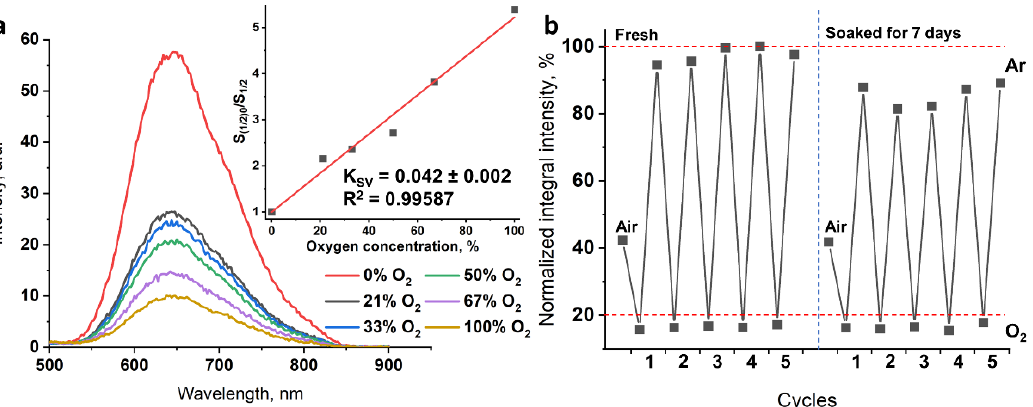
Figure 5. ( a ) Luminescence spectra of aqueous solutions of 1 0.5 @pU in different mixtures of O 2 /Ar atmosphere and under air conditions (21% of oxygen). The insert is a plot of S (1/2)0 /S (1/2) vs. oxygen concentration and its linear approximation. ( b ) The value of integrated luminescence intensity for the left part of the spectra up to 645 nm under air, 100% O 2 , and 100% Ar for fresh and soaked samples. At each point the solution was saturated with gases for 3 min.